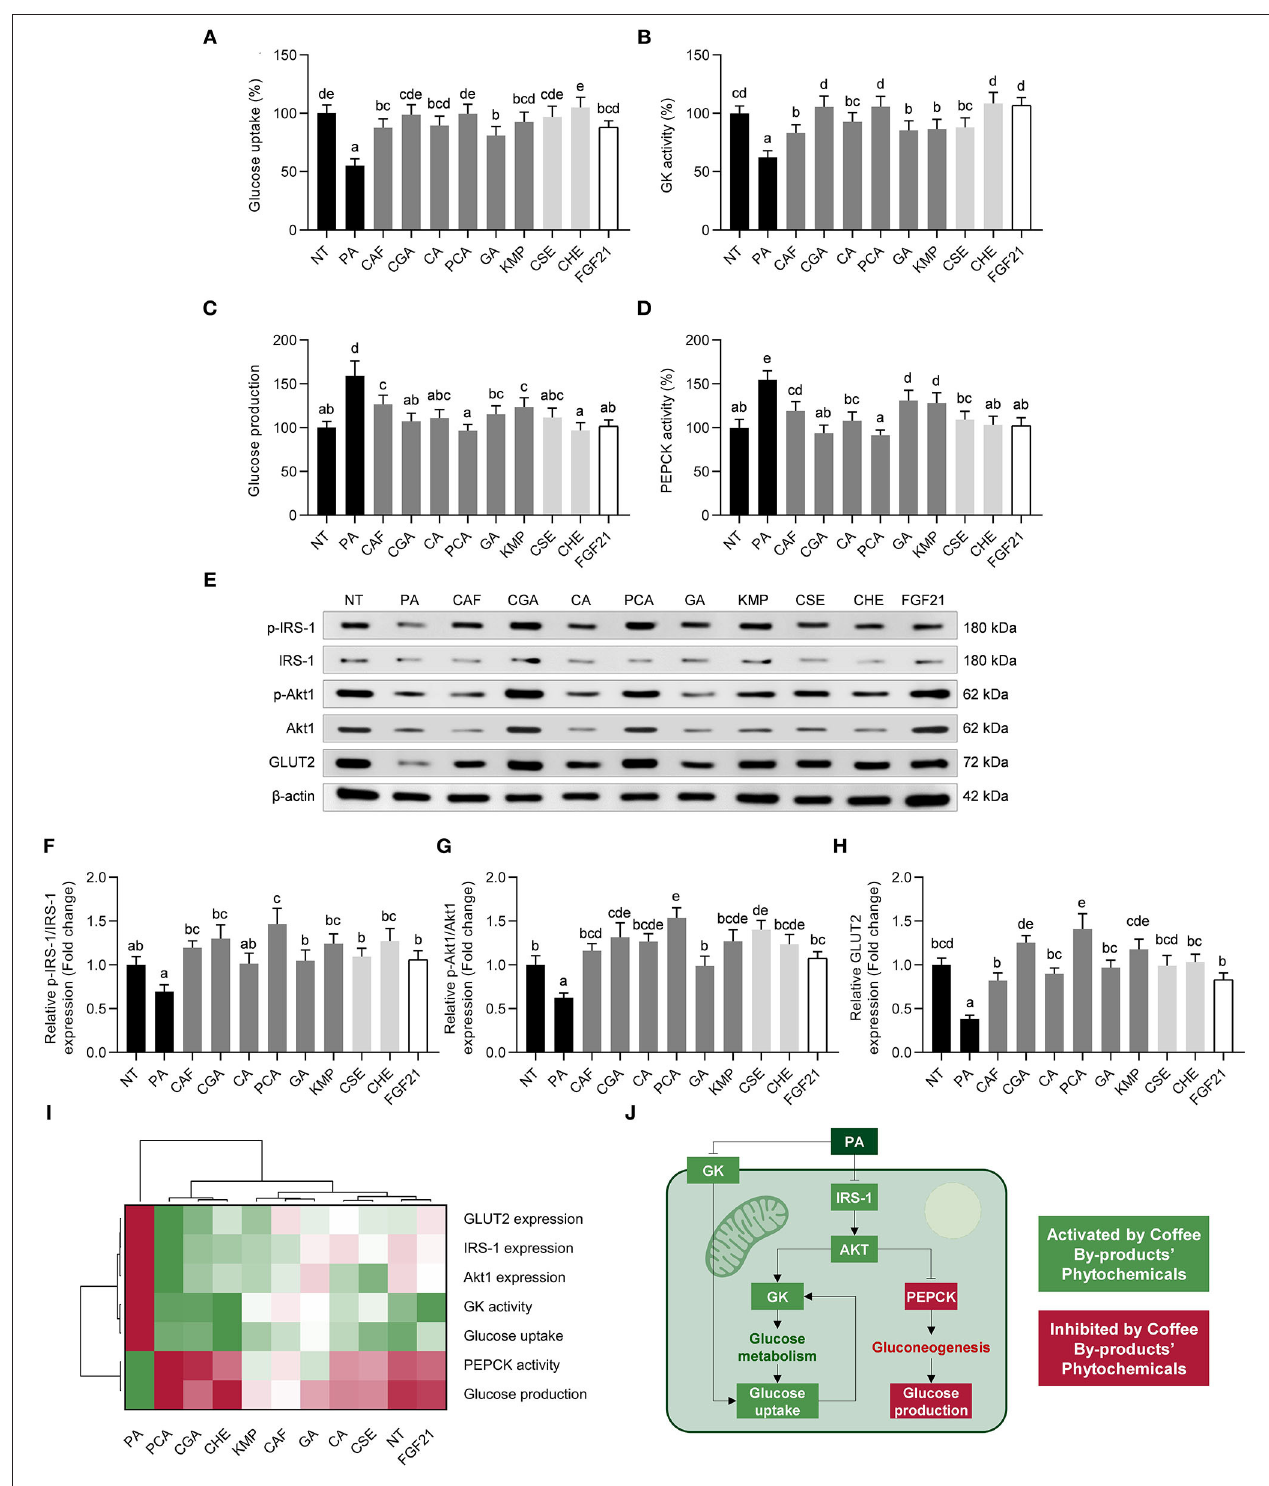
FIGURE 8 | Regulatory role of standard solutions of the bioactive compounds from coffee by-products (50 µ mol L − 1 ), aqueous extracts (CSE and CHE, 100 µ g mL − 1 ), and FGF21 (20 nmol L − 1 ), in the presence of palmitic acid (500 µ mol L − 1 ) on glucose metabolism in HepG2 human hepatocytes. Hepatocytes exhibited a modulation on glucose uptake (A) , glucokinase (GK) activity (B) , glucose production (C) , phosphoenolpyruvate carboxykinase (PEPCK) activity (D) , insulin receptor